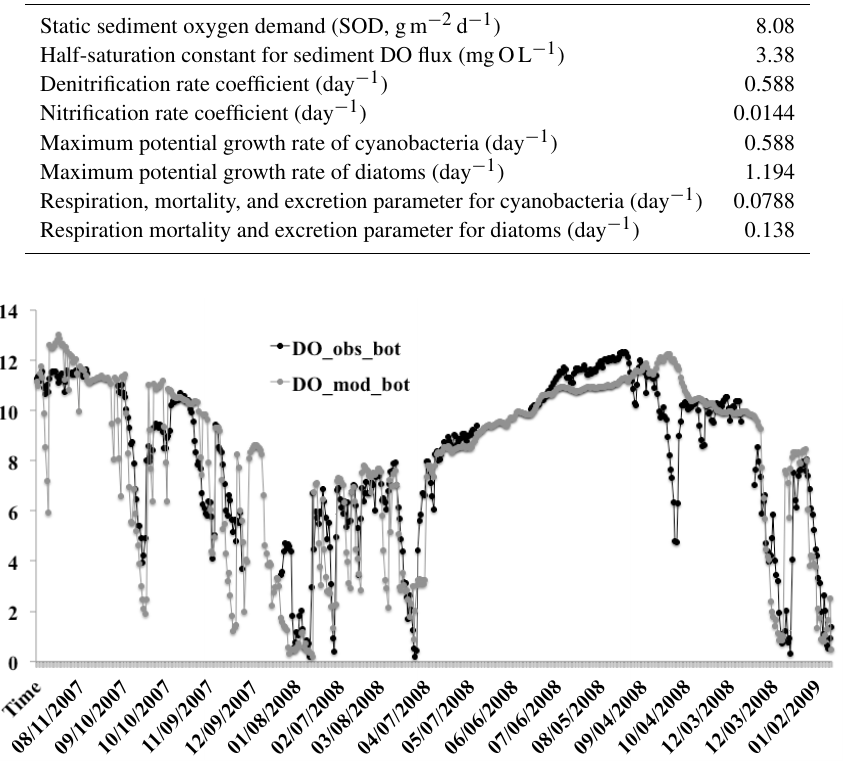
erage observation value (8.40 mg L − 1 ) by 3.5 mg L − 1